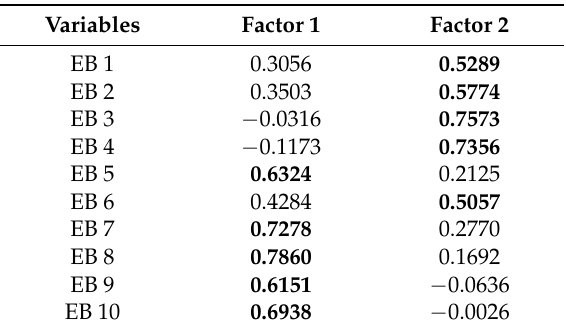
Table 2. Rotated Factor